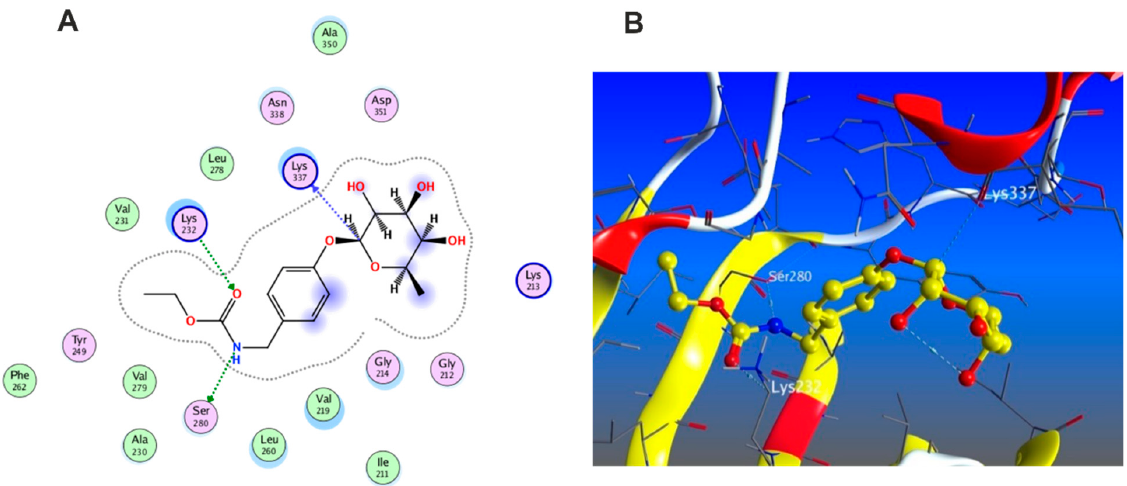
Figure 13. Docking results of compound 16 in the active pocket site of (TGF- β ) (6B8Y): ( A ) 2D interactions of compound 16 ( B ) 3D Docking pose of compound 16 .